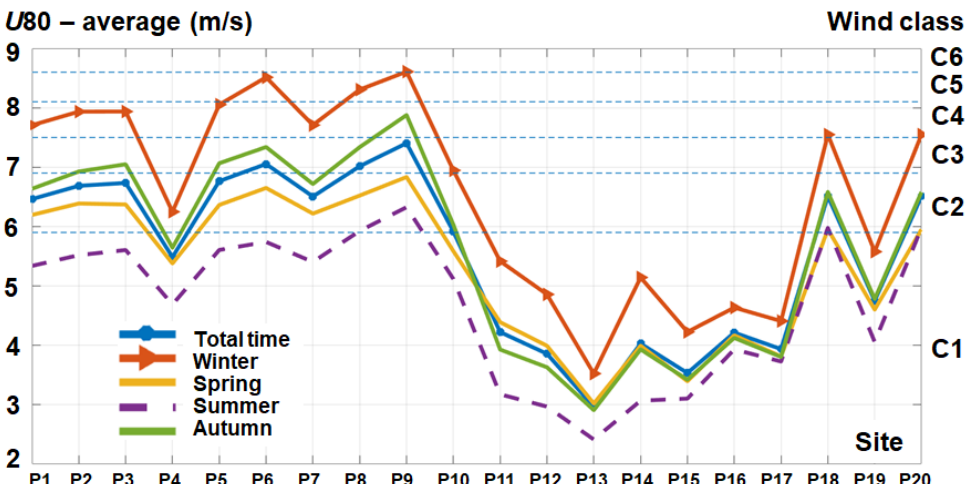
Figure 4. Distribution of the U 80 average values corresponding to the full time distribution and the representative seasons, considering the ERA-Interim data (January 1998–December 2017). The wind class levels (C1–C6) are also indicated.